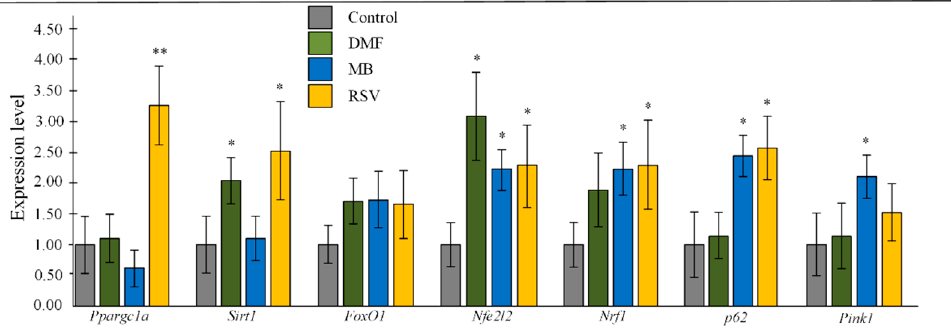
Figure 4. Expression of transcriptional factors in the hippocampus. The results expressed as means ± SEM. Control n = 8, DMF = 9, MB = 6, RSV = 7. * p < 0.05, ** p < 0.01, comparison of control group and treated groups using Tukey’s post-hoc test.